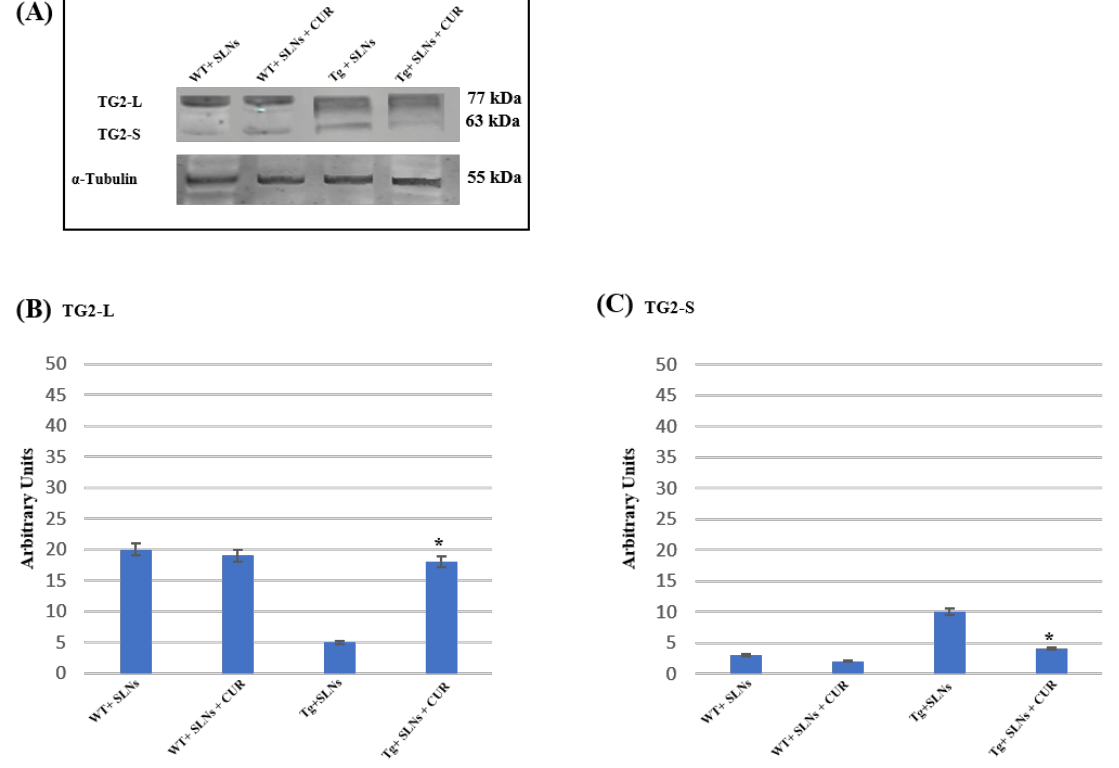
Figure 2. ( A ) Western blotting analysis for both TG2 isomers expression levels in total cellular lysates from WT-SLNs, WT-SLNs-CUR, Tg-SLNs, and Tg-SLNs-CUR mice systemically administrated for 3 weeks. ( B ) Densitometric analysis of TG2-L and ( C ) TG2-S expression relieved after α -tubulin normalization. The results are expressed as the mean ± S.D. of the values of n.5 separate experiments in triplicate. * p < 0.05 Tg-SLNs-CUR vs. Tg-SLNs.